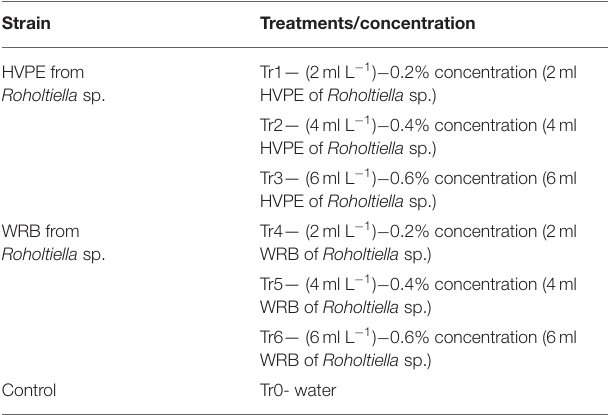
TABLE 1 | The concentrations of Roholtiella sp. extracts and biomass. Strain Treatments/concentration HVPE from Roholtiella